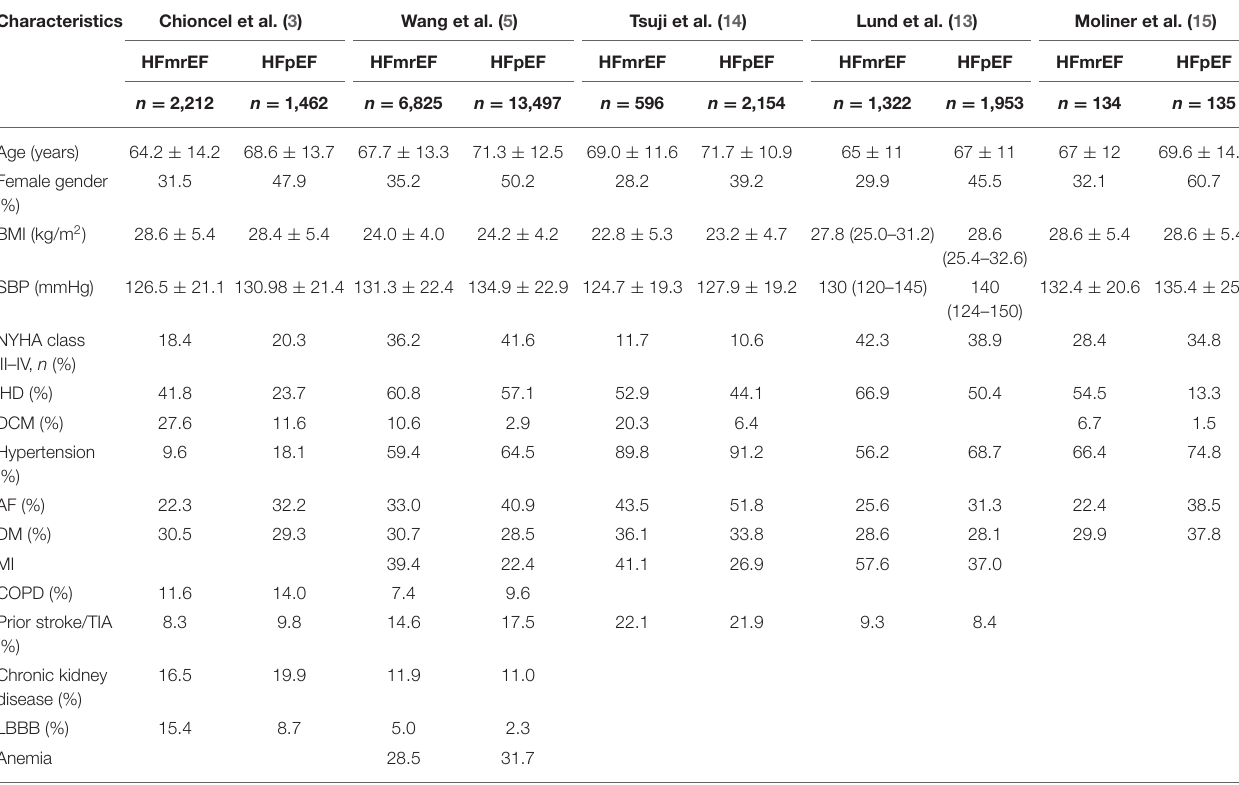
TABLE 1 | Baseline characteristics of patients with HFmrEF and HFpEF. Characteristics